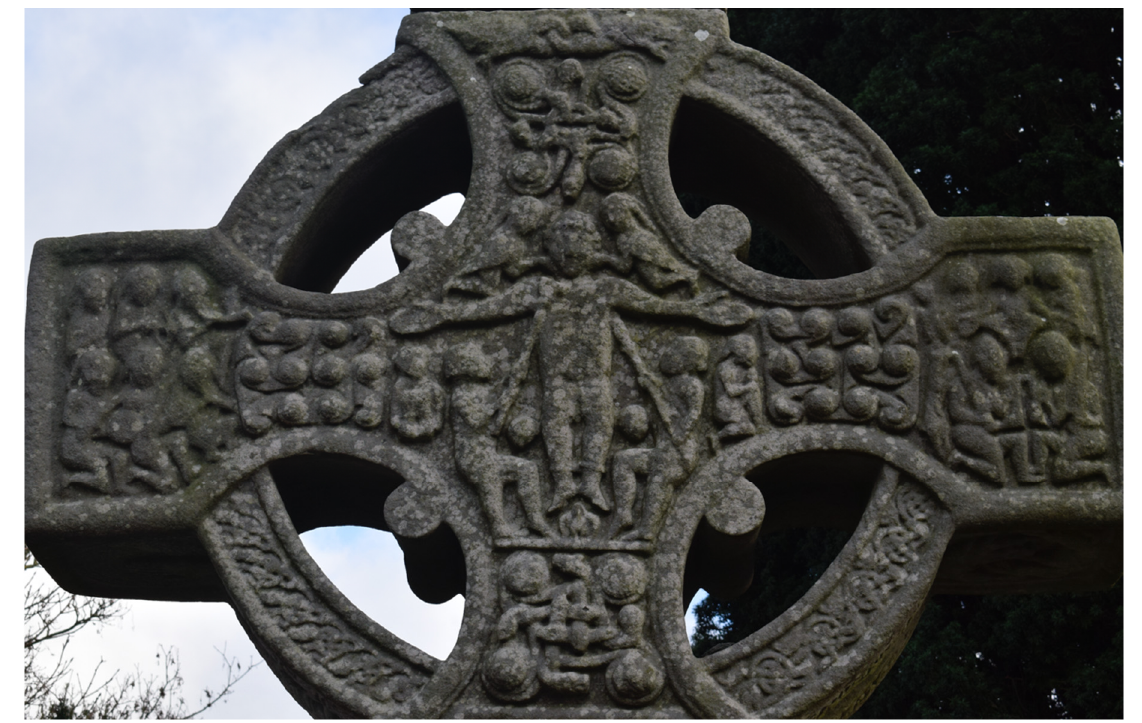
Figure 6. Crucifixion, Muiredach Cross at Monasterboice (tenth century, Co. Louth, Ireland). (Photograph: the author).